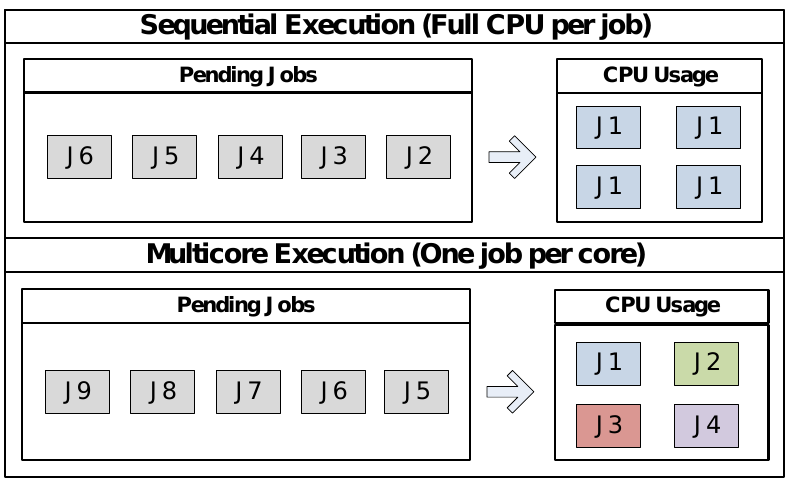
Figure 13. Examples of different execution